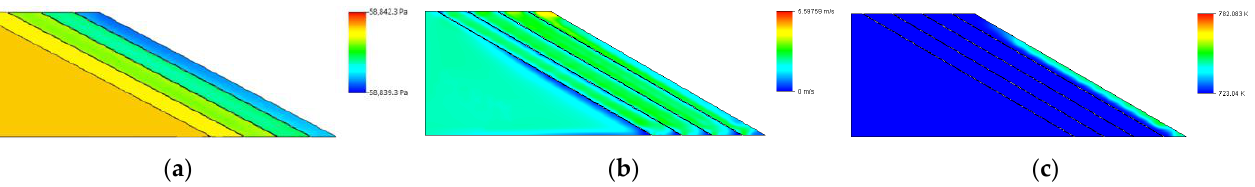
Figure 3. The data on the ( a ) pressure, ( b ) velocity, and ( c ) temperature profiles for the cyclone.